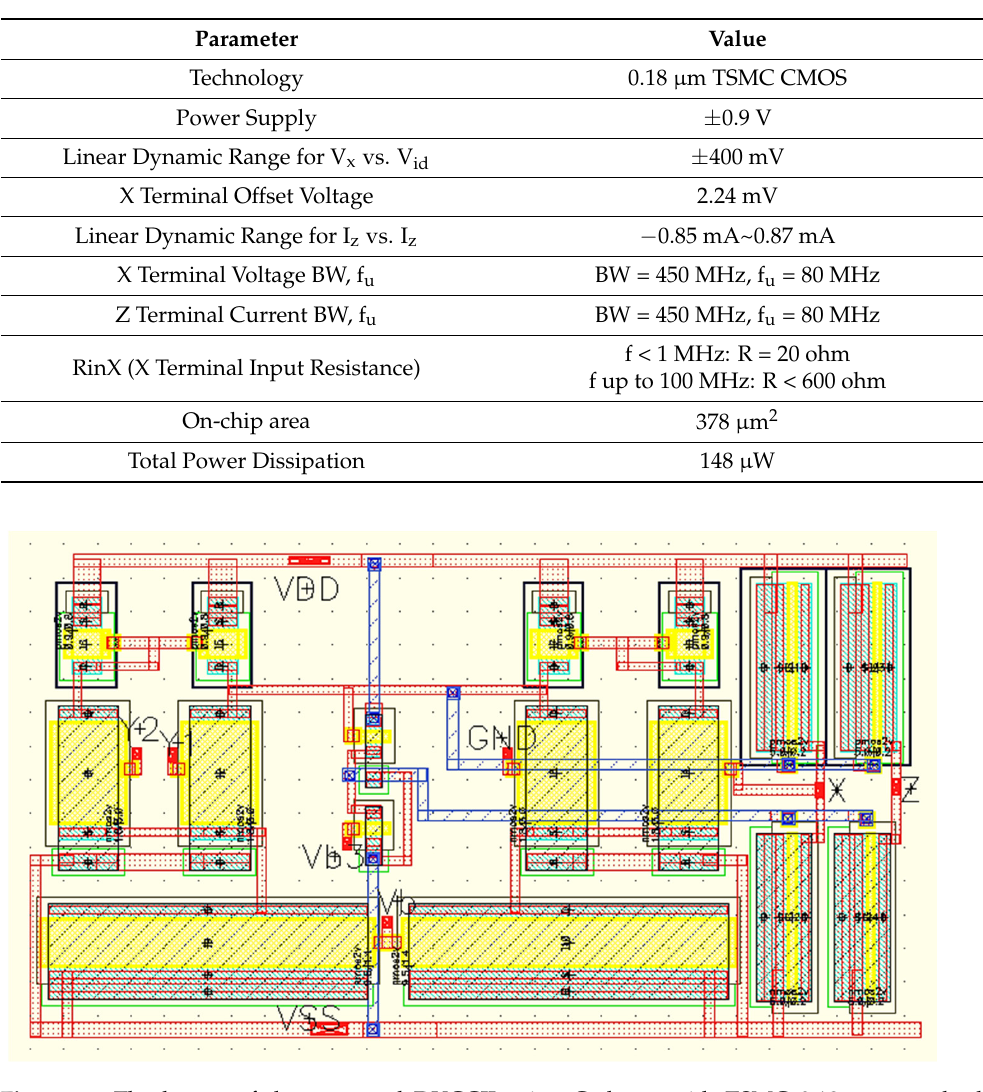
Figure 6. The layout of the proposed DVCCII using Cadence with TSMC 0.18 μ m standard CMOS technology.